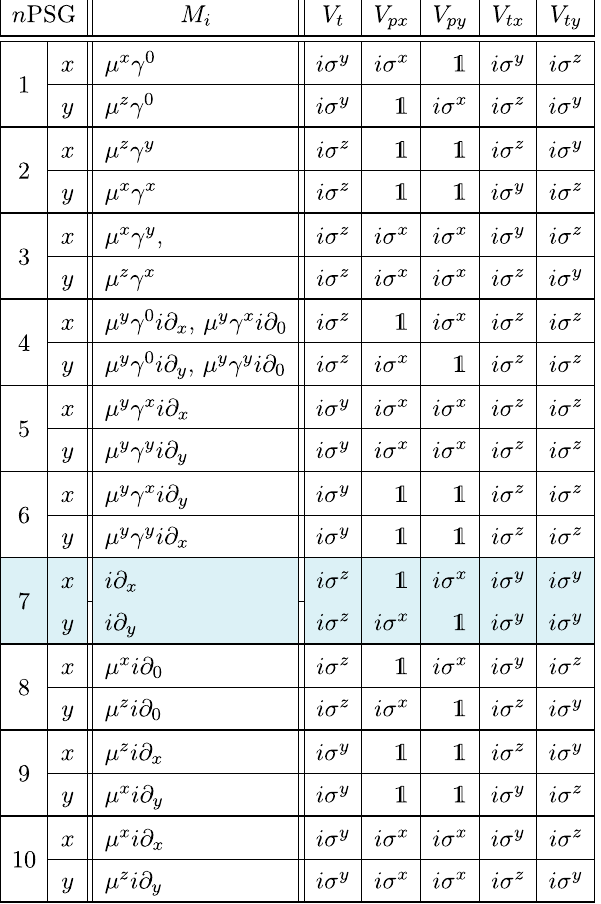
FIG. 7. Nematic PSGs associated with order parameters of the ¯ X μ y X ¯ XM i X form Φ a tr ð σ a tr ð σ a Þ þ Φ a 2 Þ . We do not include i